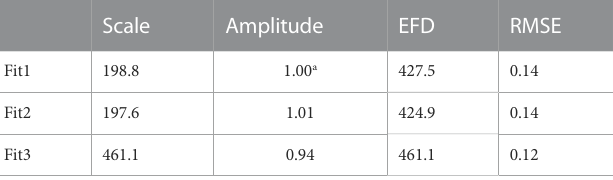
TABLE 2 The scale parameter ( α − 1 ), amplitude A ), effective e-folding distance (EFD), and root-mean-square error (RSME) for three fi ts to vertical snow depth correlations. All units are in m except for the dimensionless